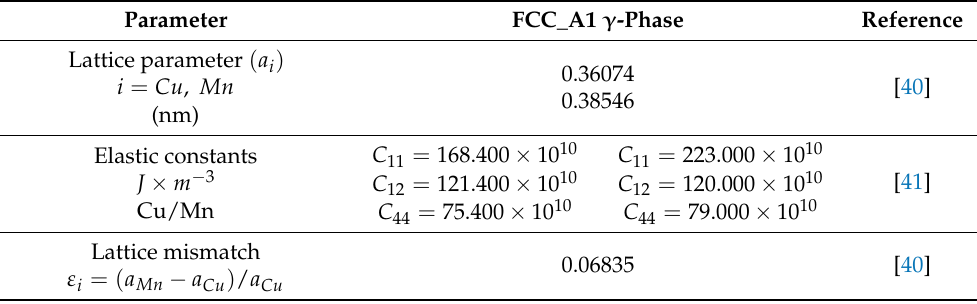
Table 2. Elastic parameters for the calculation of mechanical